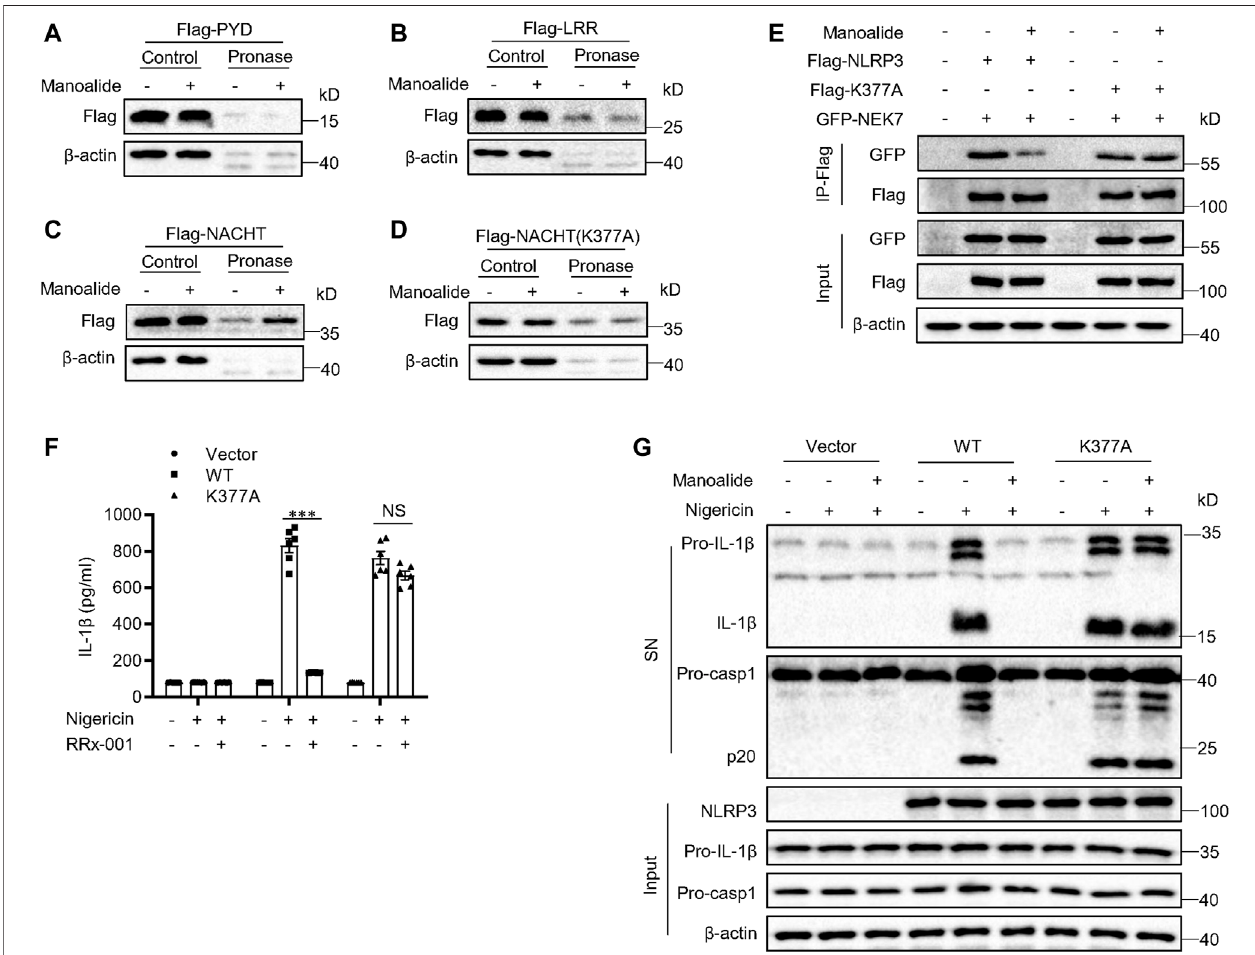
FIGURE 6 | Manoalide binds to lysine 377 of NLRP3. DARTS analysis of (A) Flag-NACHT, (B) Flag-PYD, (F) Flag-LRR, (G) Flag-NACHT (C409A) from lysates of HEK-293T cells transfected with indicated plasmids in the presence or absence of 50 μ M manoalide. (E) Western blot analysis of immunoprecipitation to evaluate the NLRP3-NEK7interactionorNLRP3(K377A)-NEK7interactioninthelysatesofHEK-293Tcellspretreatedwith2 μ Mmanoalide. (F) ELISAofmatureIL-1 β or (G) western blot analysis of the mature IL-1 β and activated caspase-1 in supernatant from LPS-primed Nlrp3 − / − BMDMs reconstituted with WT NLRP3 or NLRP3 K377A that werepretreatedwith 500 nM manoalide before stimulation withnigeicin.Dataare derived from three independent experiments (F) and displayed as mean and SEM ( n = 3) or represent three independent experiments (A-E,G) . Statistically signi fi cant difference was calculated by unpaired Student ’ s t-test: *** p < 0.001; NS, not signi fi cant.